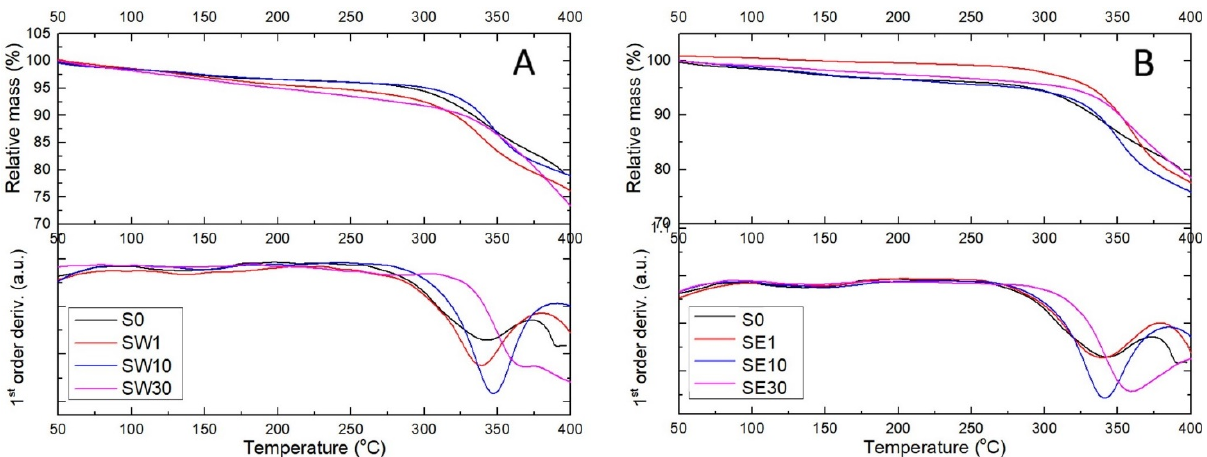
Figure 5. Thermogravimetric analysis of RF-modified membranes using water ( A ) and an ethanol–water mixture ( B ) as the solvents in the impregnation process performed in air at a heating rate of 10 °C/min.